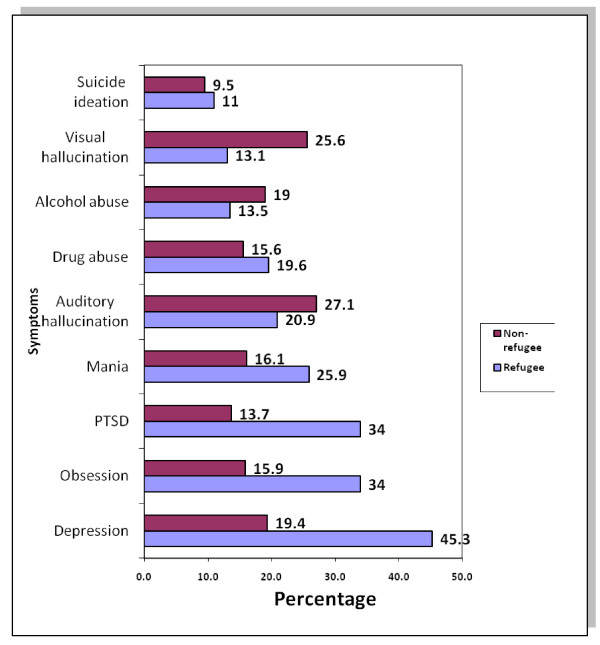
Proportion of respondents reporting mental health disorders by status.